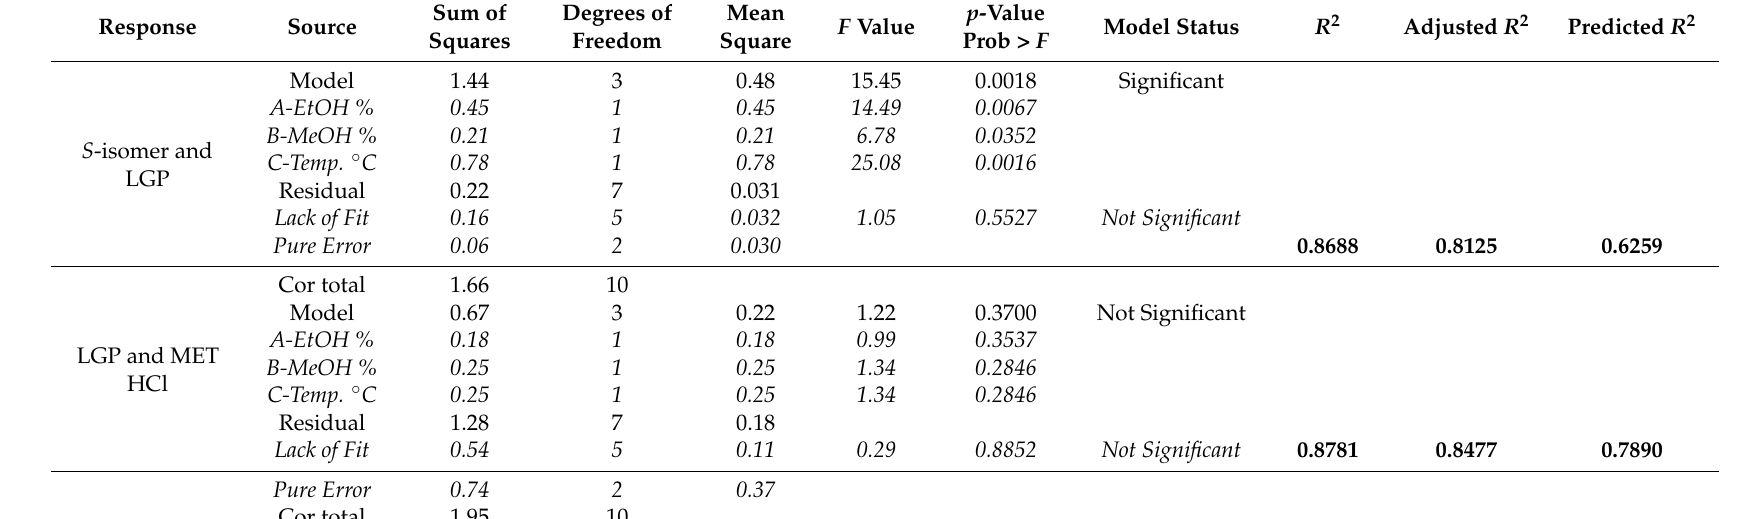
Table 3. Analysis of variance (ANOVA) for the selected factorial model, used for prediction and model plots obtained with Design Expert.